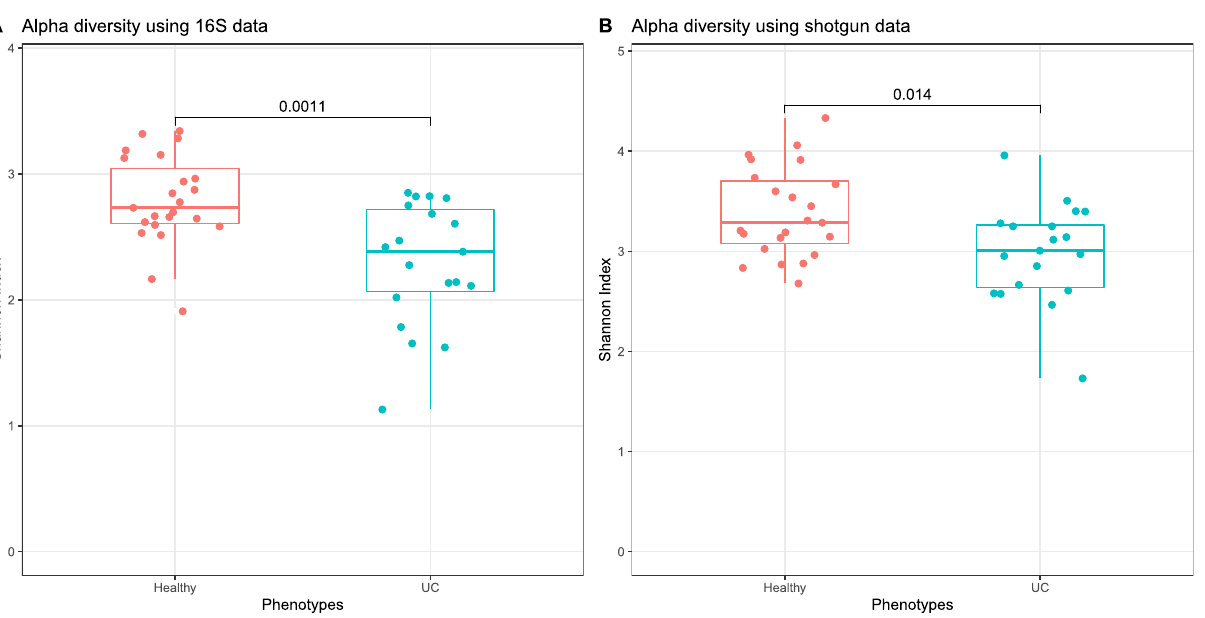
Figure 2. Box plots of Shannon indices for gut samples of pediatric UC cases and healthy controls stratified by disease status. P-values were calculated using the Wilcoxon rank sum test. ( A ) Shannon indices were